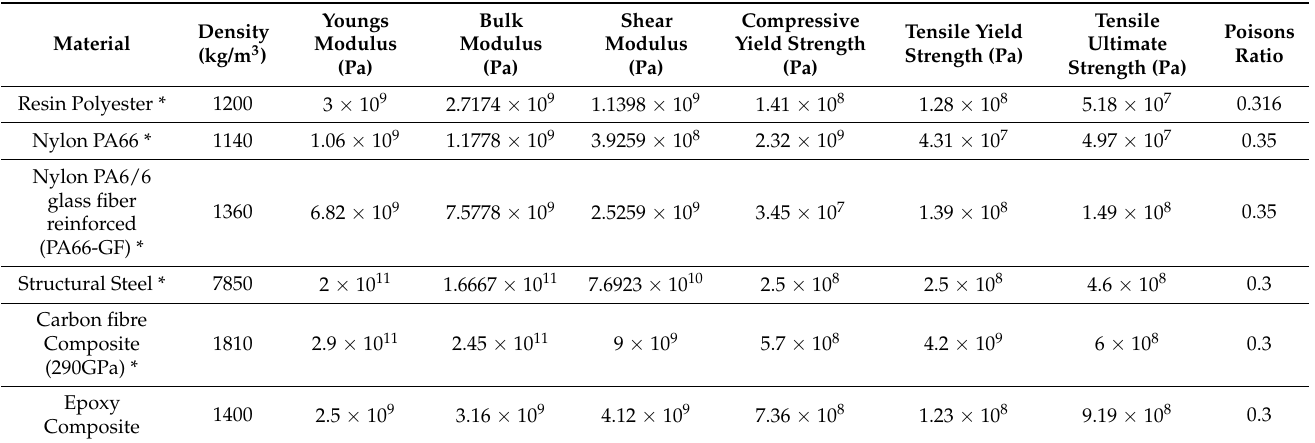
Table 2. The Mechanical Properties of the Reeling Model